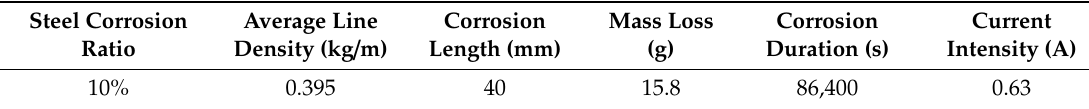
Table 2. Applied current value for theoretical mass loss.